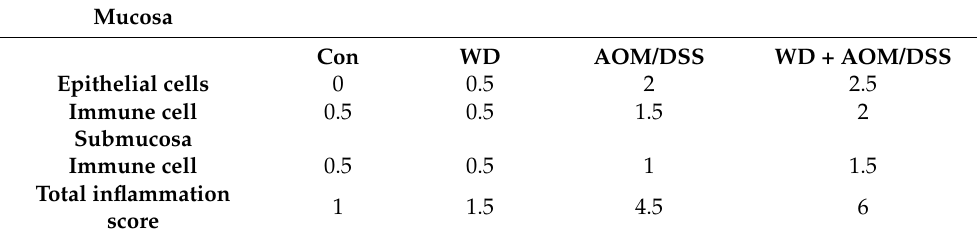
Table 4. Inflammation scores.